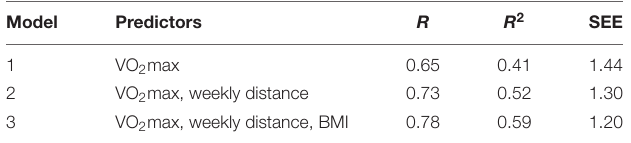
TABLE 2 | Training, anthropometric, and physiological characteristics in the experimental ( n = 65) and control group ( n = 65).